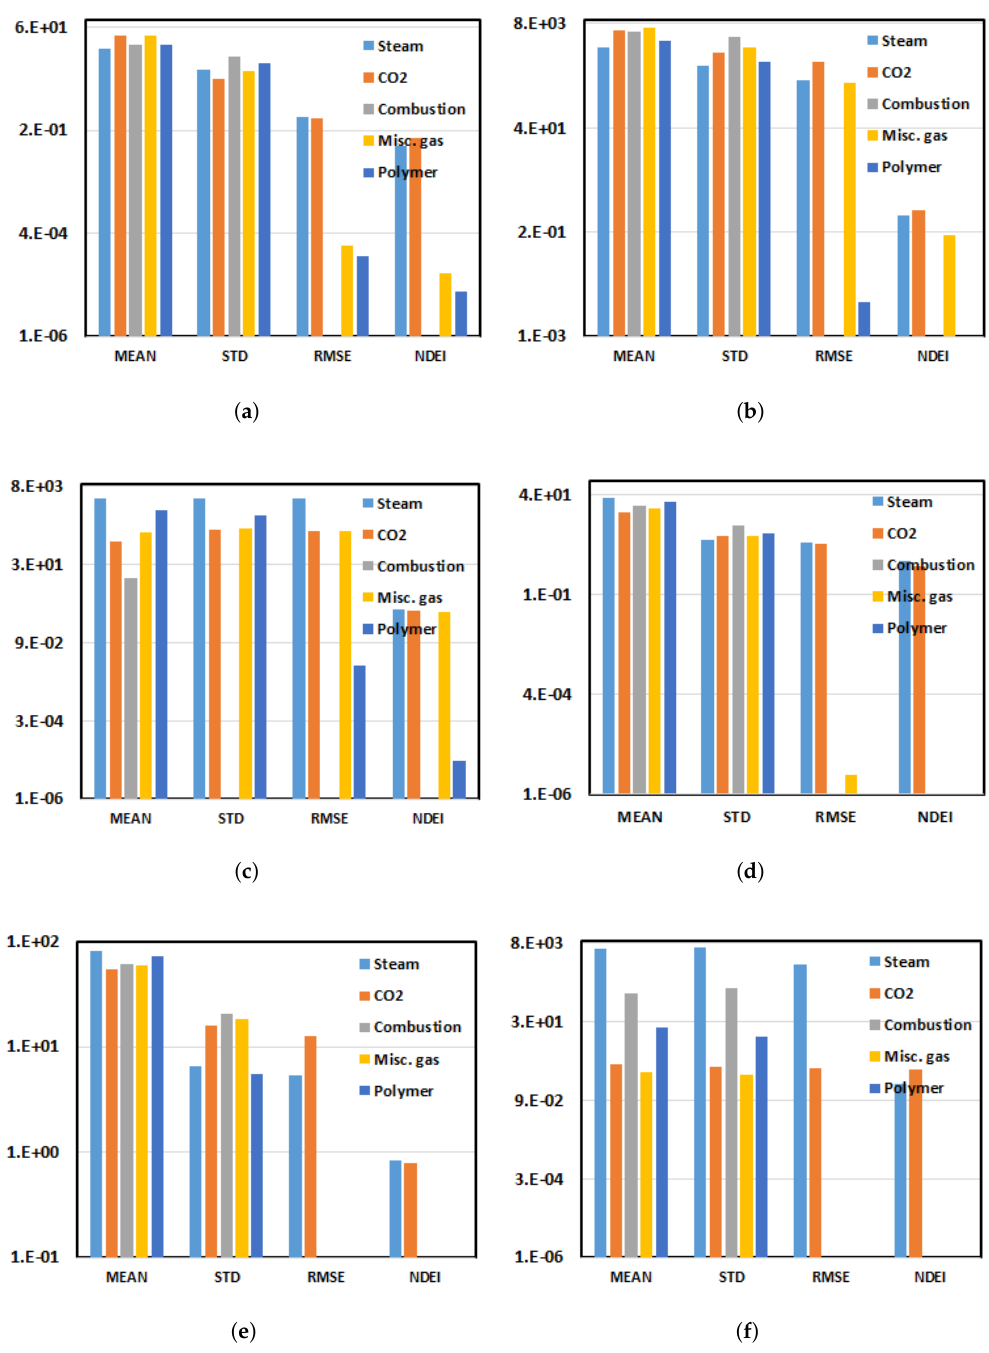
Figure A9. Statistical data plots of steam, CO 2 , combustion, miscible gas and polymer injection for Area 4 of the Angolan oilfield (See Table 4 for the area clarification). Variables include: ( a ) API; ( b ) depth; ( c ) permeability; ( d ) porosity; ( e ) saturation; and ( f )